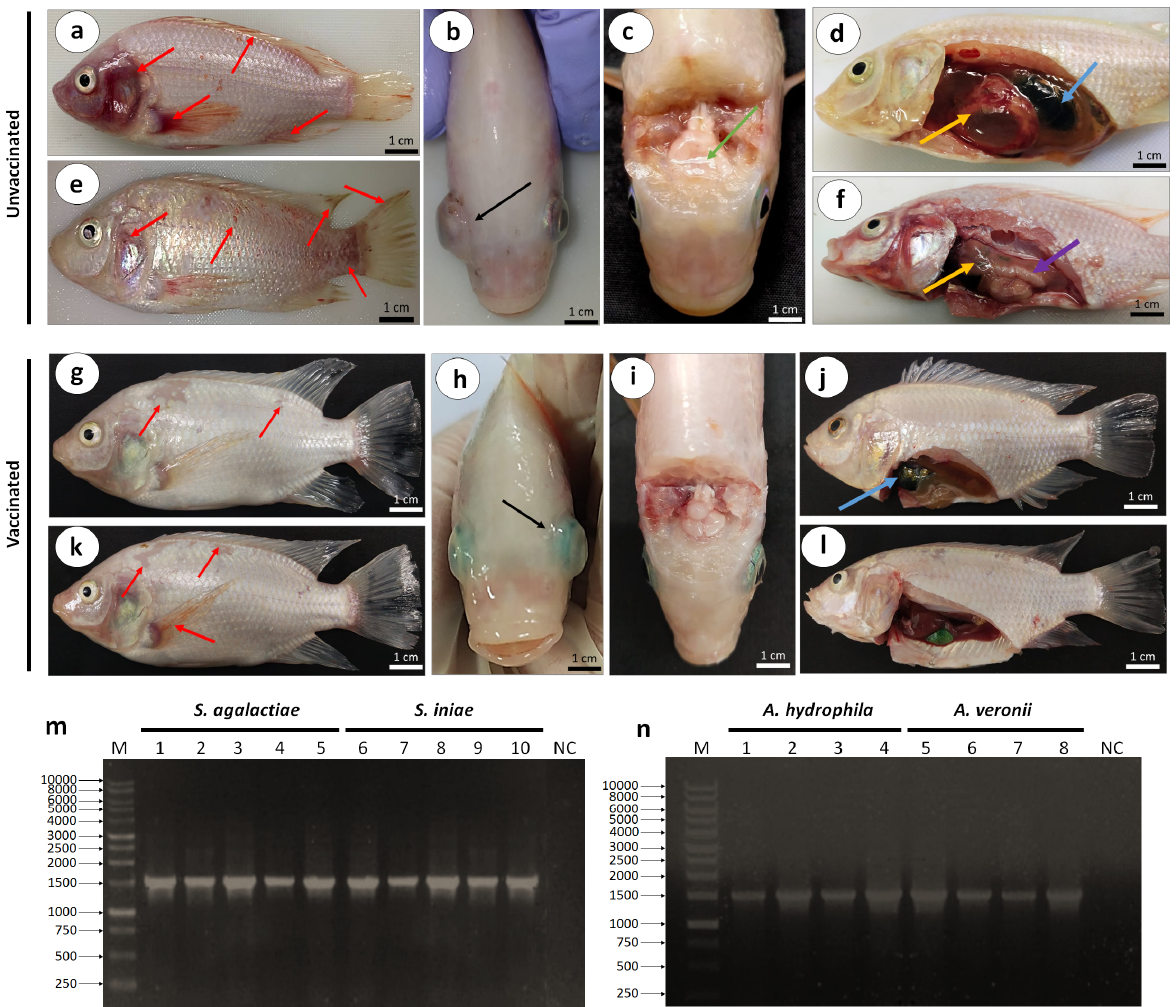
Figure 4. Gross lesions shown by red hybrid tilapia following challenge with Streptococcus spp. or Aeromonas spp. ( a – d ) The gross lesions shown by unvaccinated fish that were challenged with Streptococcus spp. ( e , f ) Gross lesions shown by unvaccinated fish following challenge with Aeromonas spp. ( a ) Hemorrhages in the skin of operculum, and the dorsal, caudal and pectoral fins (red arrow). ( b ) Bilateral exophthalmia (black arrow). ( c ) Softening of the brain (green arrow). ( d ) An enlarged liver (yellow arrow) and swelling of the gall bladder (blue arrow). ( e ) Hemorrhages in the skin of operculum, and the dorsal, caudal, and pectoral fins (red arrow). ( f ) Pale liver (purple arrow), an enlarged liver (yellow arrow). Picture ( g – l ) are gross lesions observed in vaccinated fish. ( g ) Hemorrhages affecting the scales (red arrow). ( h ) Bilateral exophthalmia (black arrow). ( i ) Normal brain. ( j ) Swelling of gall bladder (blue arrow). ( k ) Hemorrhages in the skin (scales and pectoral fin) (red arrow). ( l ) Normal liver and gall bladder. ( m ) Amplification of 16S rRNA gene sequence of Streptococcus spp. isolated from the eye (lanes 1 and 6), brain (lanes 2 and 7), spleen (lanes 3 and 8), liver (lanes 4 and 9), and kidney (lanes 5 and 10) of the infected dead fish. ( n ) Amplification of the 16S rRNA gene sequence of Aeromonas spp. isolated from a skin lesion (lanes 1 and 5), liver (lanes 2 and 6), kidney (lanes 3 and 7), and spleen (lanes 4 and 8) of the infected dead fish. Lane NC, negative control; lane M = 1 kb DNA ladder marker (Fermentas, Waltham, MA,